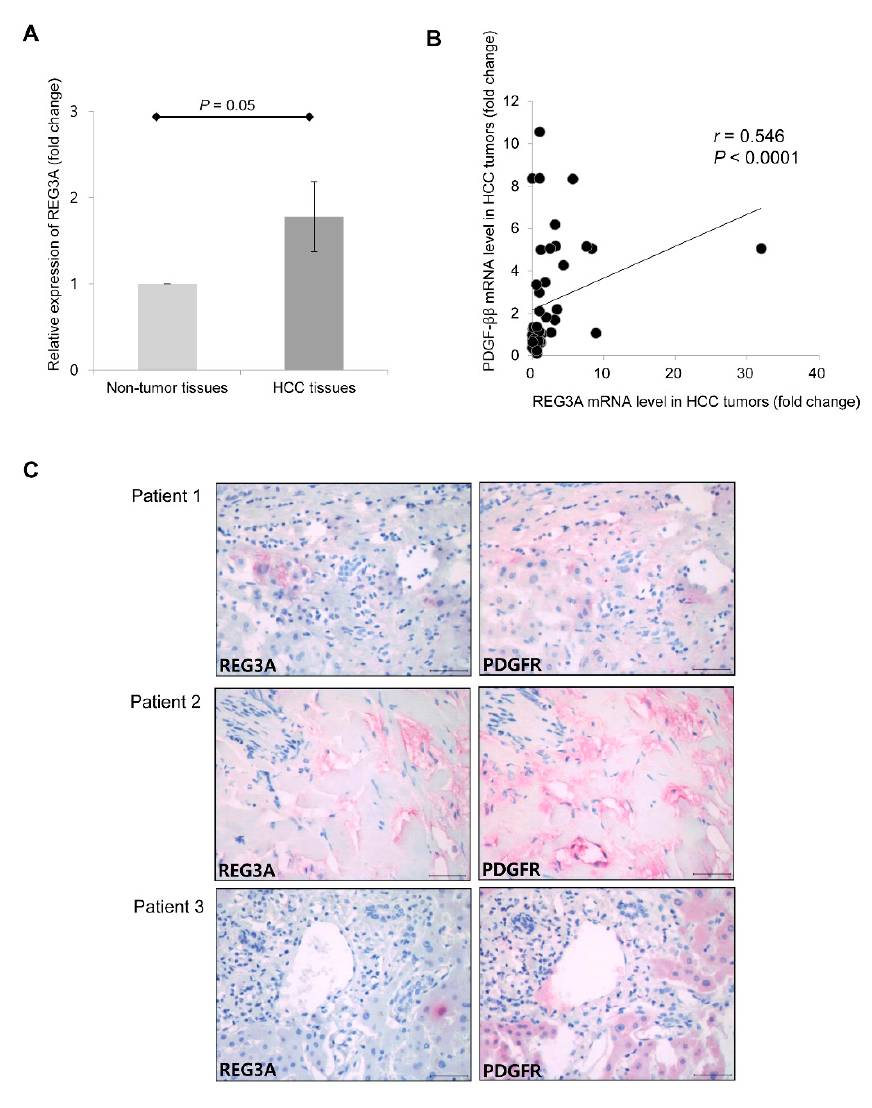
Figure 6. The mRNA level of REG3A was positively correlated with PDGF- ββ in human HCC tissue. ( A ) The mean mRNA expression of REG3A was upregulated 1.8-fold in HCC tissues compared with non-tumor tissues ( n = 88). The data are expressed as mean ± SD. ( B ) The mRNA expression of REG3A was positively correlated with PDGF- ββ (Pearson’s coefficient = 0.546; p < 0.001). ( C ) Expression of REG3A and PDGF receptor (PDGFR) in three human HCC tissues were detected by immunohistochemistry (400 × magnification). Scale bars, 50 μ m.